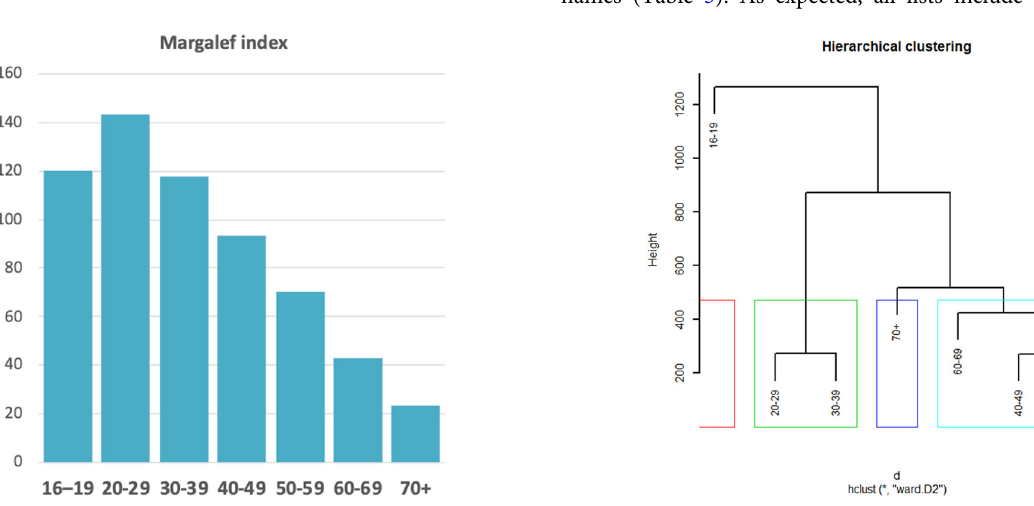
Fig. 4 The Margalef diversity index. Richness of color vocabulary of the participants of the seven age groups.